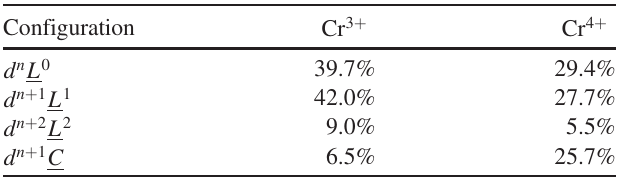
TABLE I. Ground-state contributions obtained for Cr 3 þ and Cr 4 þ core-level spectra shown in Fig.